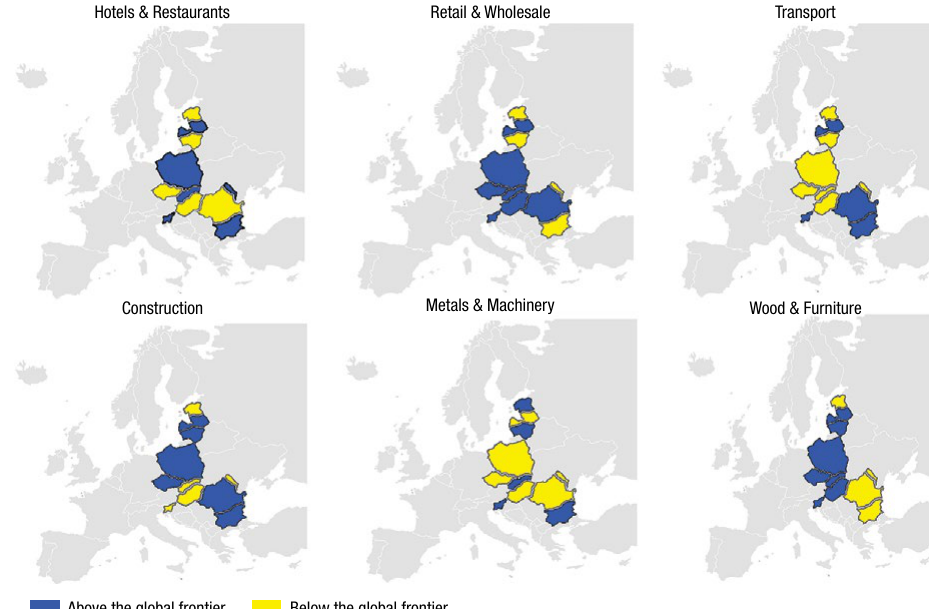
Fig. 3. Levels of efficiency firms by both sectors and country according global